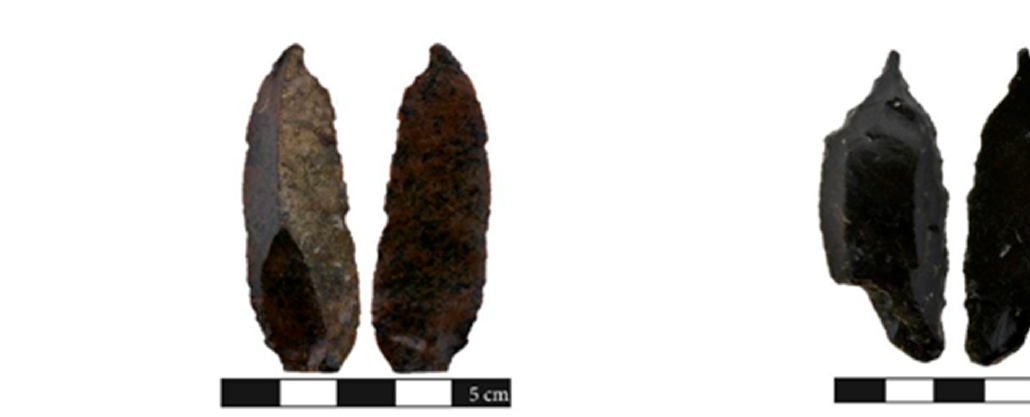
Figure 4. Retouched blade and bore samples from Kendale Hecala.